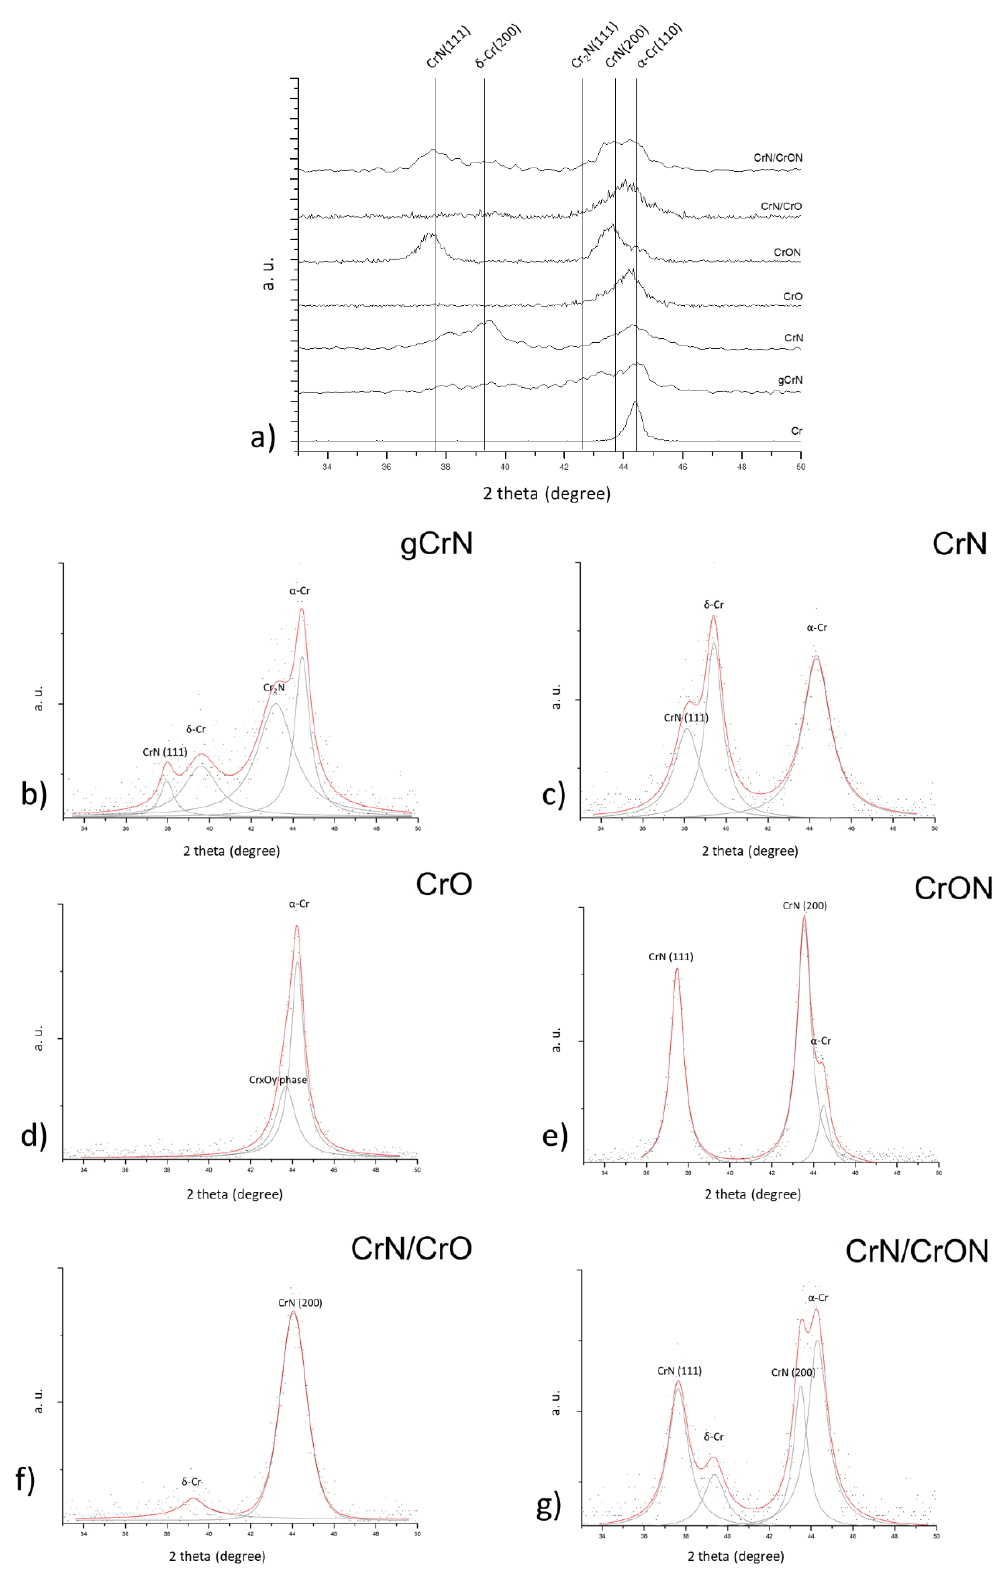
Figure 7. XRD patterns of the deposited coatings, ( a ) plot of all XRD specta for comparison purposes. Individual detailed analysis of the XRD spectra of the different coatings: ( b ) gCrN; ( c )CrN; ( d ) CrO; ( e ) CrON; ( f ) CrN/CrO and ( g ) CrN/CrON. Starting from the monolayer metallic chromium coating, Cr, an intense reflection close to 2θ = 44.4° corresponding to the (110) plane was observed for the b.c.c α -Cr, ac- cording to ICCD card no. 01-085-1335.